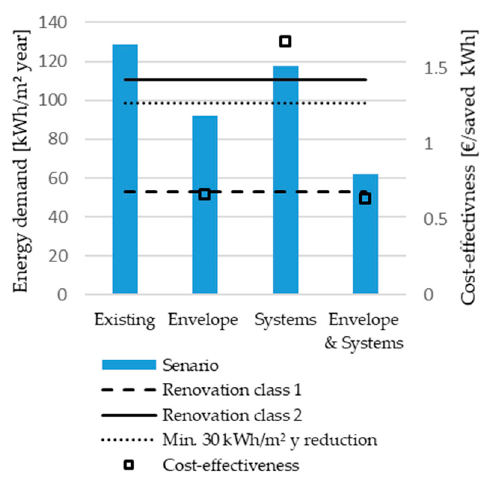
Figure 5. Results of primary energy demand for existing state and applied global renovation packages. Global cost-effectiveness values (right y-axis) and limits for renovation classes according to Danish building regulations 2018 (horizontal lines).